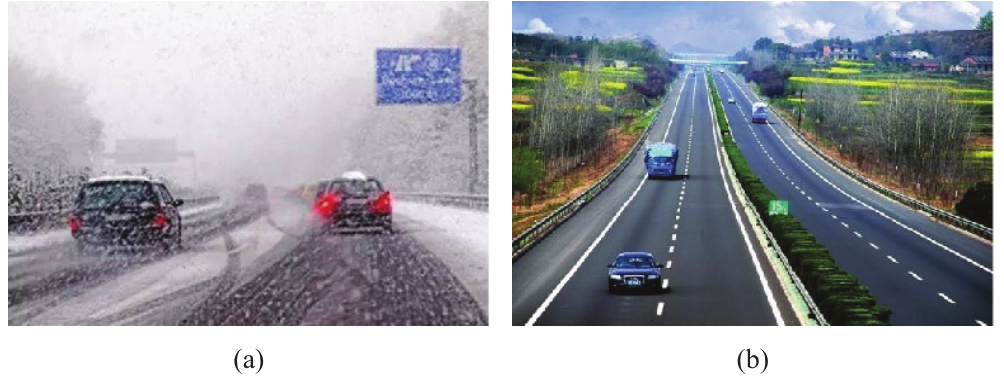
Figure 13. The impacts of weather: ( a ) bad weather; ( b ) good